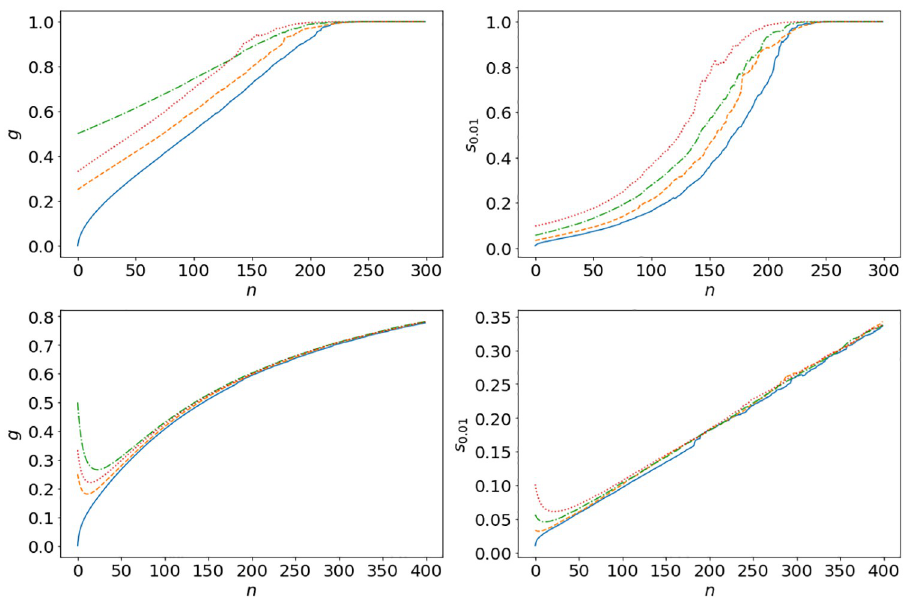
Fig 7. Gini coefficient g and top 1% wealth shares s 0.01 for simulation (3) with N = 10 6 agents, residual savings S 0, α n � nct( k , c , l , s ) with fitted parameters in (12), γ = 1.075 for top left and right and α n � 2.5 � nct( k , c , l , s ), γ = 1 for bottom left and right. The four initial conditions I.1 (full line), I.2 (dashed), I.3 (dash-dotted) and I.4 (dotted) are used with replacement mechanism R.1